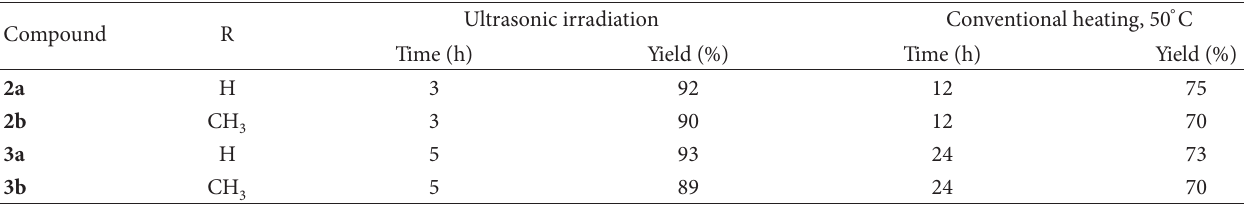
T 1: Synthesis of homoallylic alcohols by allylation of 1a,b with allylbromide (alcohols 2a,b ) and cinnamyl bromide (alcohols 3a,b ) as outlined in Scheme 1.